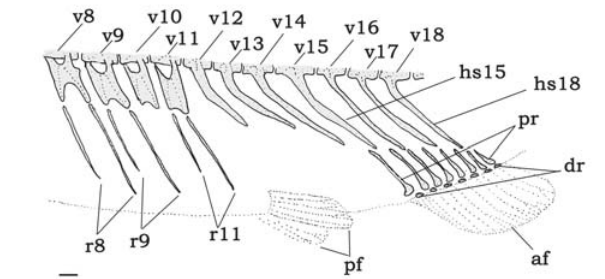
Fig. 1. Schematic representation of partial axial skeleton of Tatia boemia MCP 12949, 59.9 mm SL. Left side lateral view. Abbre- viations: af , anal fin; dr , distal radials; hs15- hs18 , hemal spines 15 and 18; pf , pelvic fin; pr , proximal radials; r8- r11 , ribs 8 to 11; v8- v18 , vertebral centra 8 to 18. Scale bar = 1.0